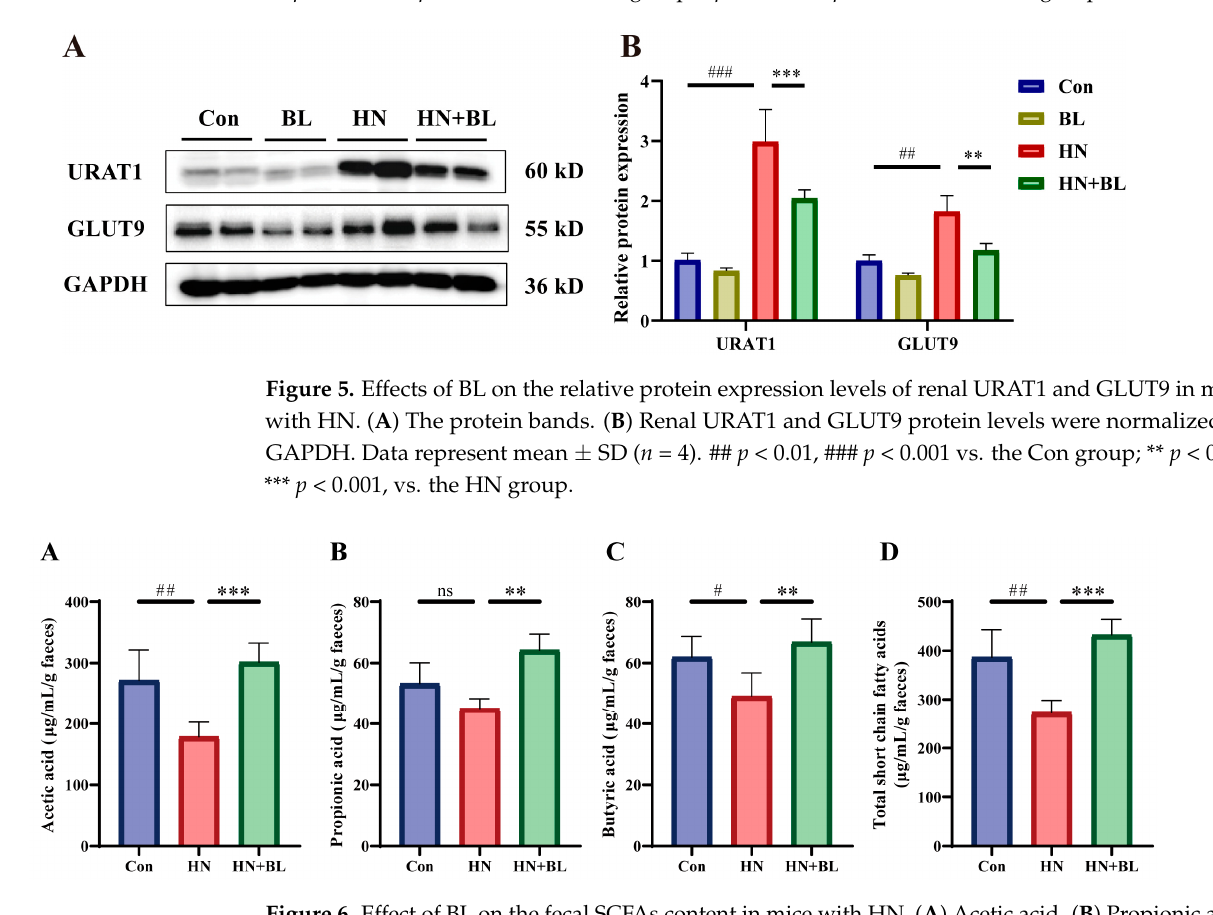
Figure 6. Effect of BL on the fecal SCFAs content in mice with HN. ( A ) Acetic acid. ( B ) Propionic acid. ( C ) Butyric acid. ( D ) Total SCFAs. Data represent mean ± SD ( n = 6). # p < 0.05, ## p < 0.01, vs. the Con group; ** p < 0.01, *** p < 0.001 vs. the HN group; ns means no significance.